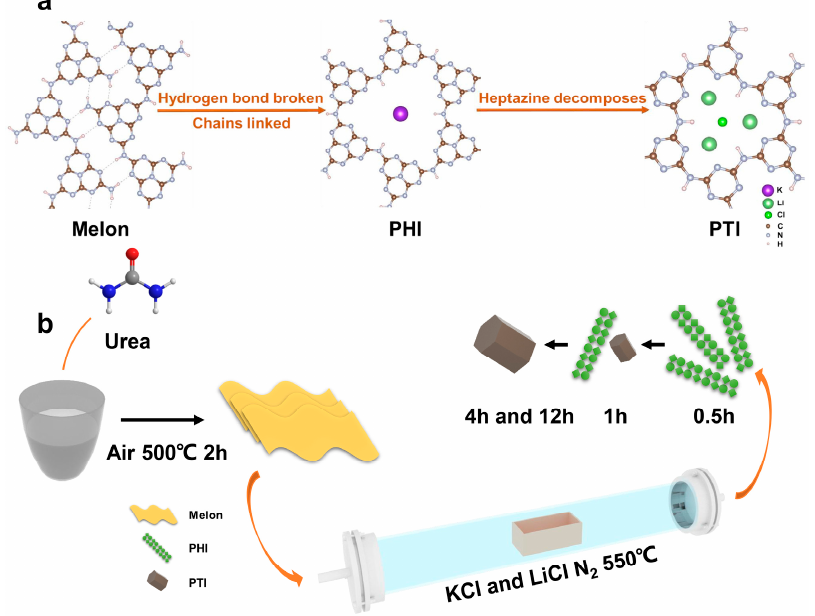
Figure 1. ( a ) Structures of melon, PHI and PTI and the proposed structural transformation pathway of g-C 3 N 4 in molten salts. ( b ) Synthesis route of crystalline g-C 3 N 4 .